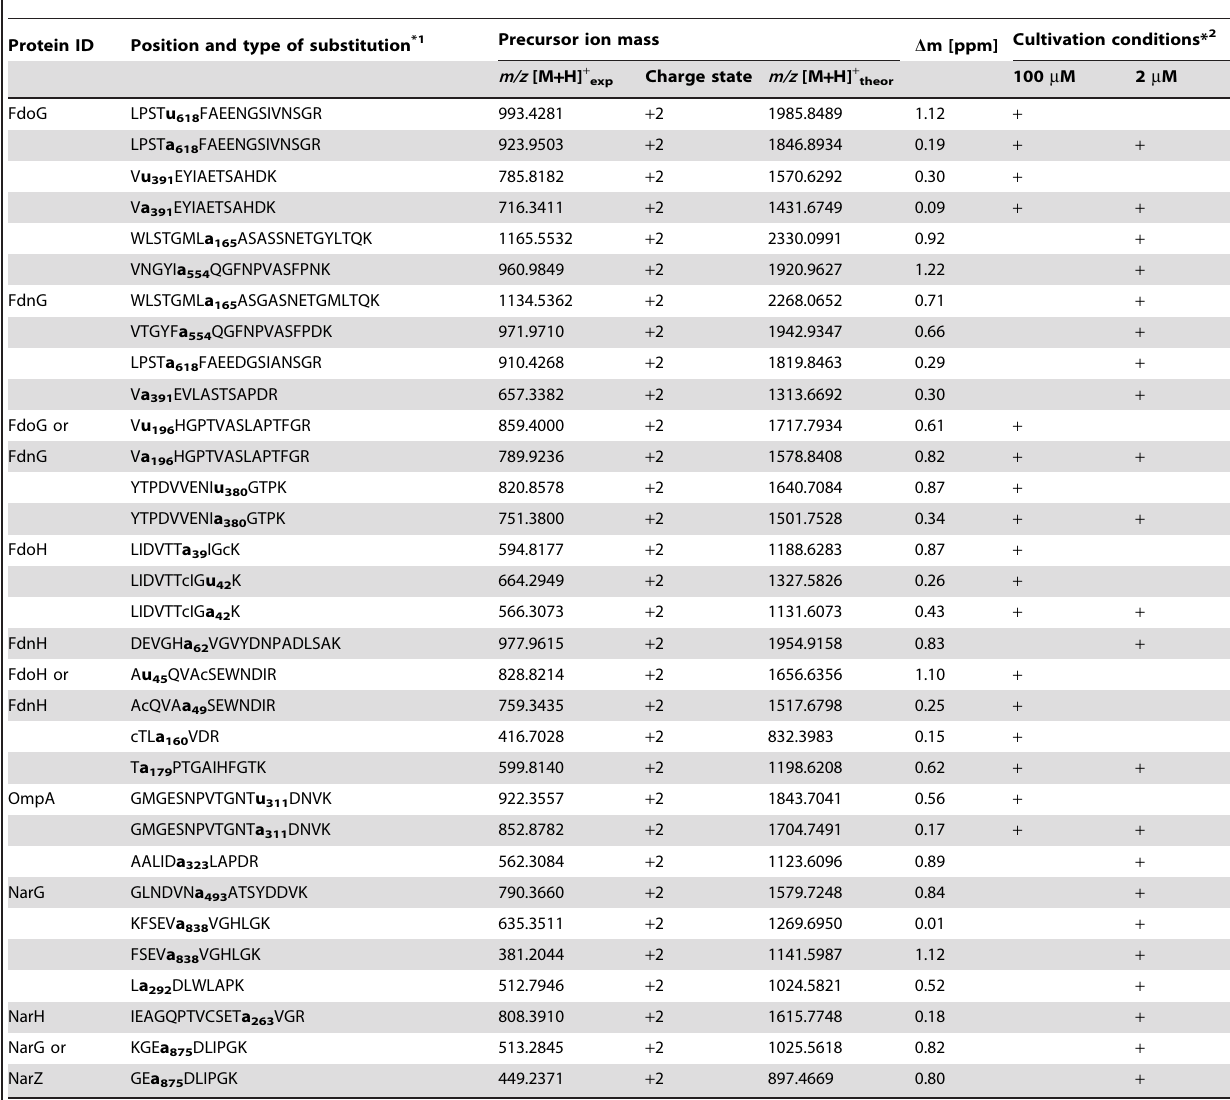
Table 2. Summary of peptides in E. coli MC4100, in which cysteines were found to be substituted by selenocysteine and dehydroalanine by